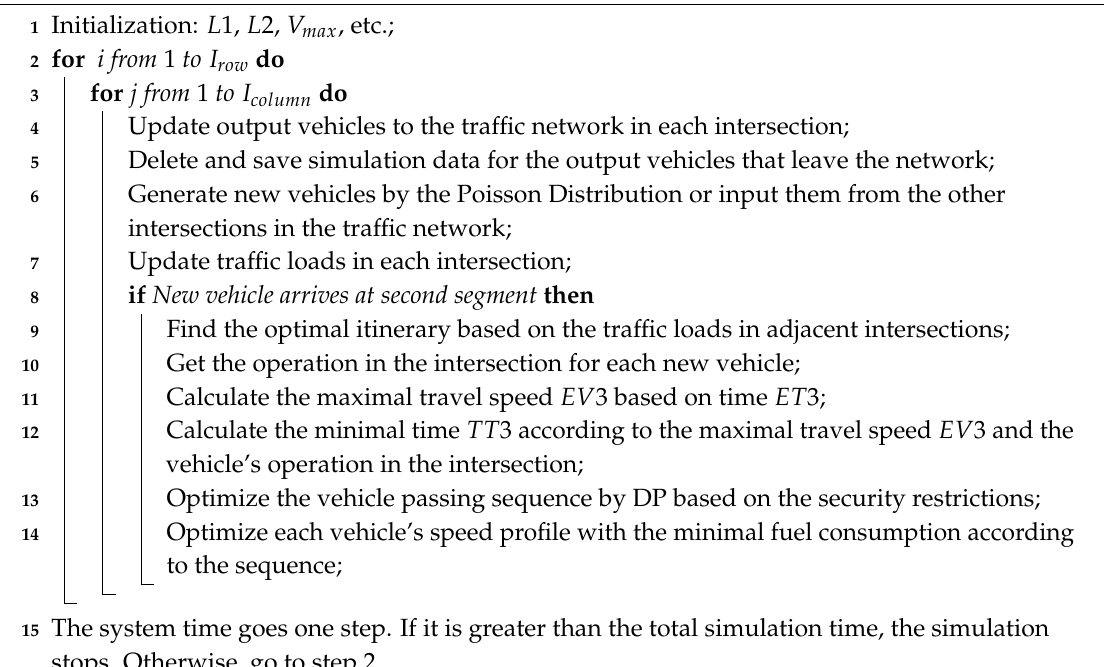
Algorithm 2: The overall process of the proposed algorithm.